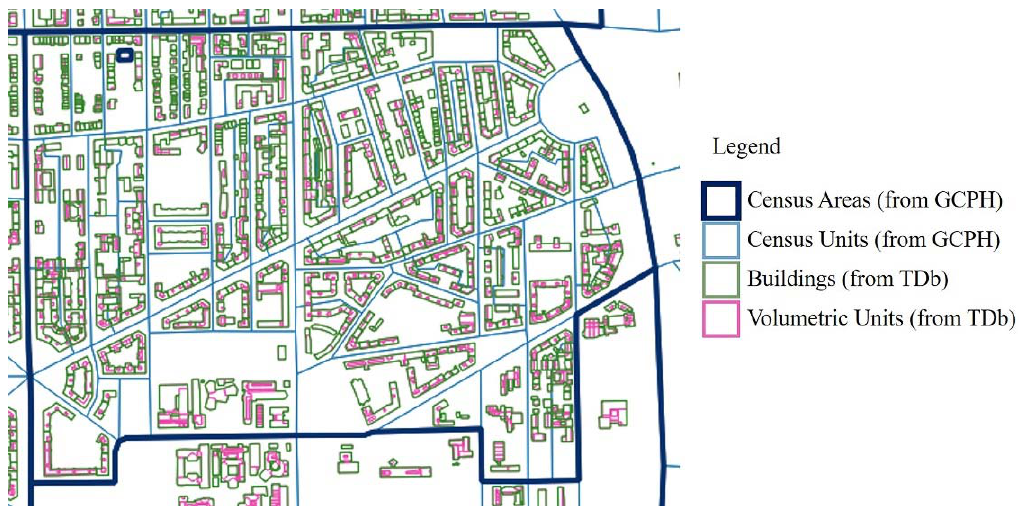
Figure 2. Used spatial data in GIS environment.